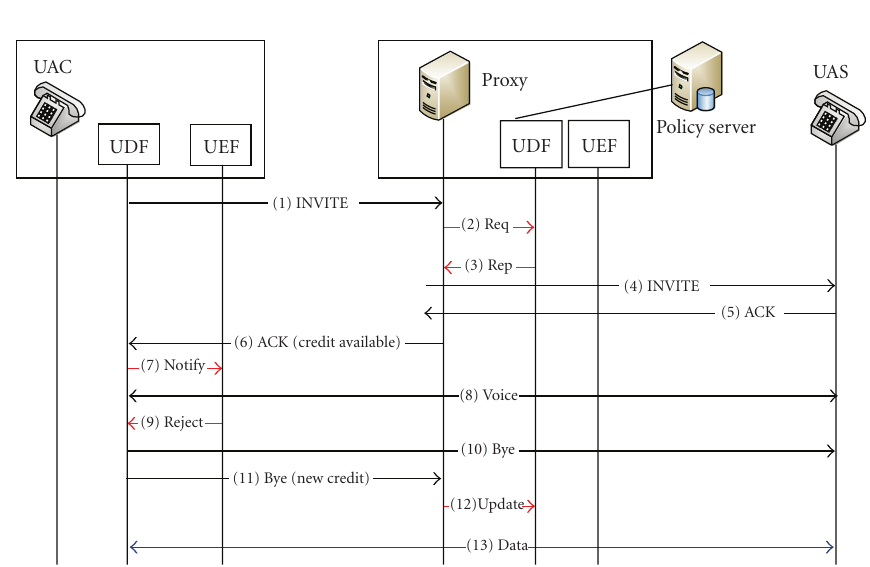
Figure 7: Authorization